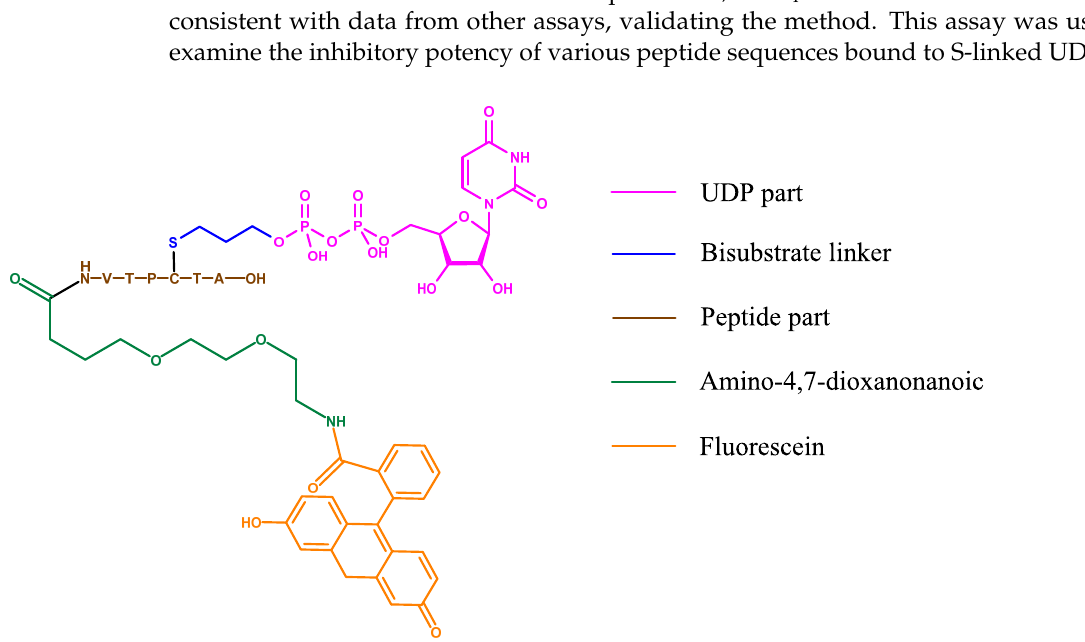
Figure 16. First quinolone-6-sulfonamide hits leading to the development of OSMI family.